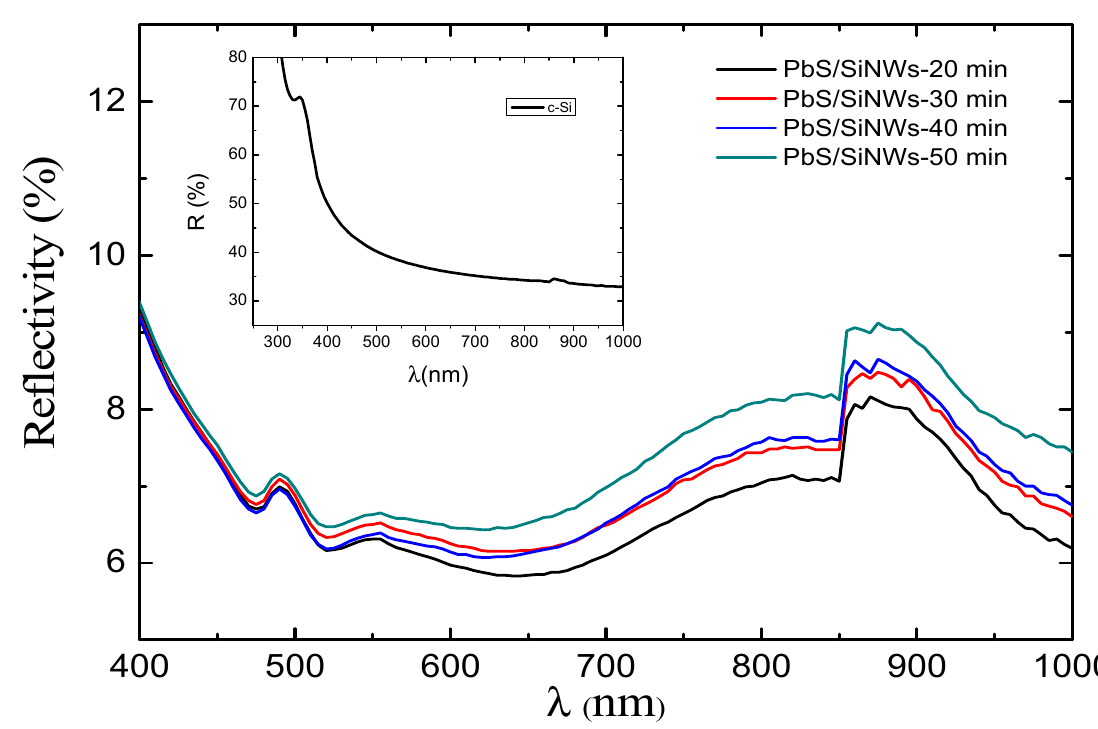
Figure 6 . Reflectivity spectrum of a PbS NPs film (N LP = 1000) deposited by PLD on different SiNWs substrates .